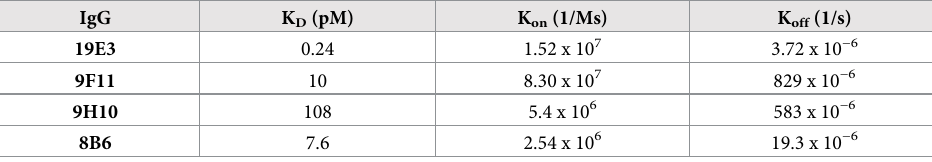
Table 1. Affinity of hybridoma clones to human